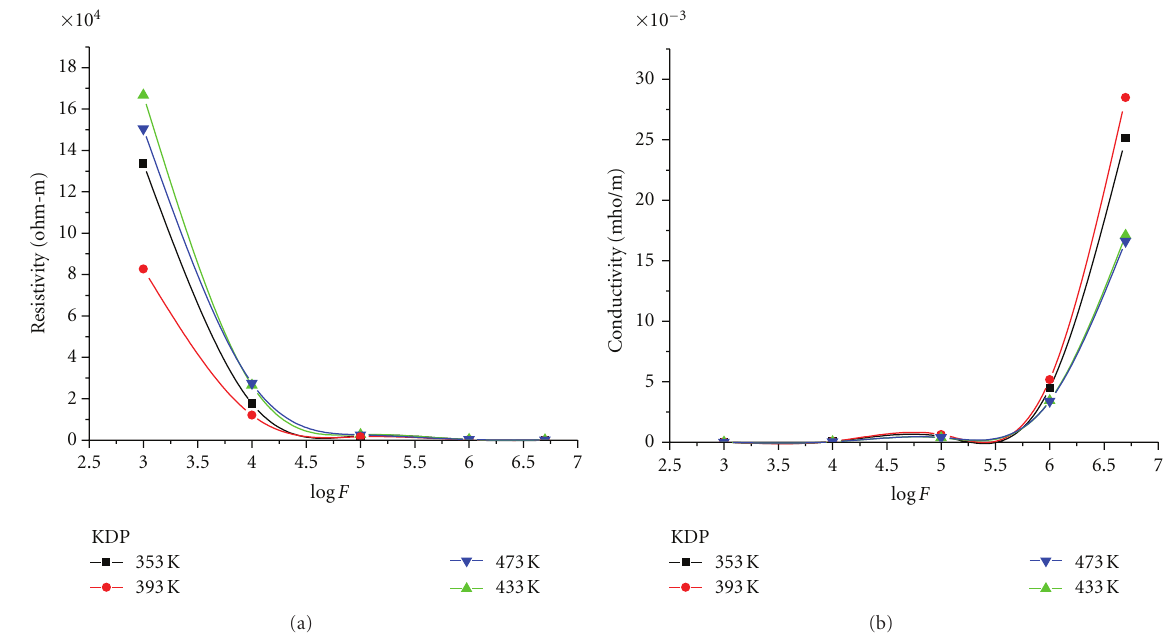
Figure 6: (a) Variation of resistivity with frequency (pure KDP). (b) Variation of conductivity with frequency (lysine-doped KDP).